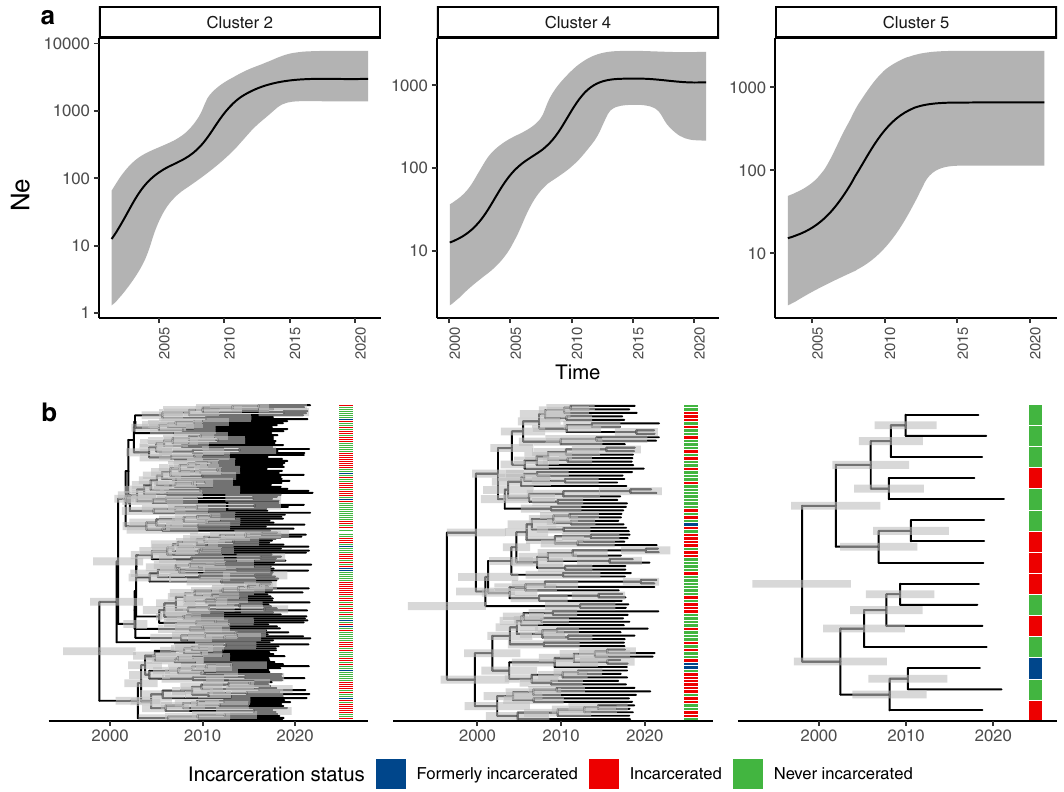
Fig. 3 | Genomic transmission clusters spanning prisons and neighboring communities have recently expanded. a Effective population size ( Ne ) estimates for the three largest genomic clusters in our sample over time. Black lines indicate Ne inferred inaBayesianSkyline Coalescent model and greyshadingindicates95% highposteriordensityestimates. b Mediancladecredibilitytreesinferredfromthe